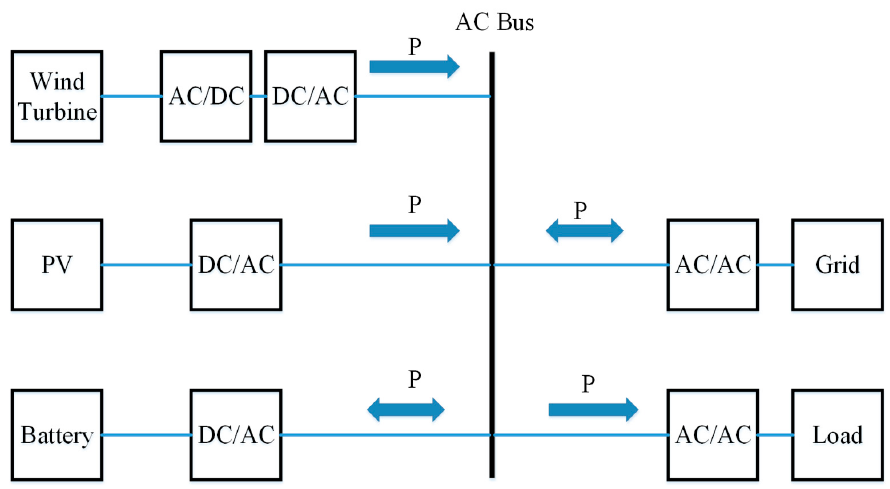
Figure 1. The general scheme of an AC microgrid. Abbreviations: AC; DC; P; PV, photovoltaics.